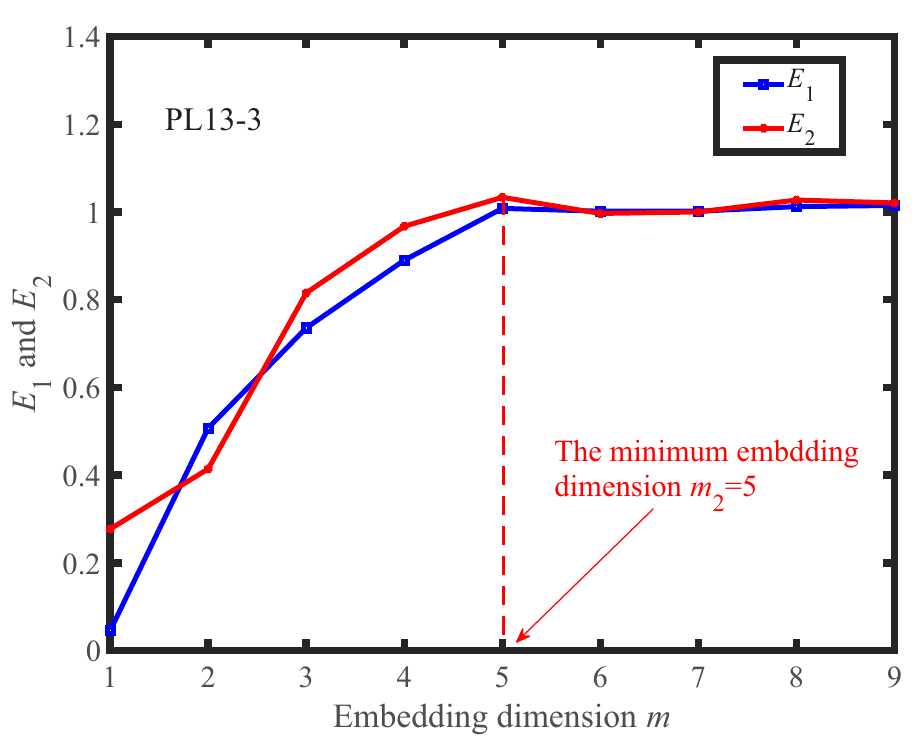
Fig 32. E 1 ( m )~ m and E 2 ( m )~ m curves for the observed displacement data series of the PL13-3.